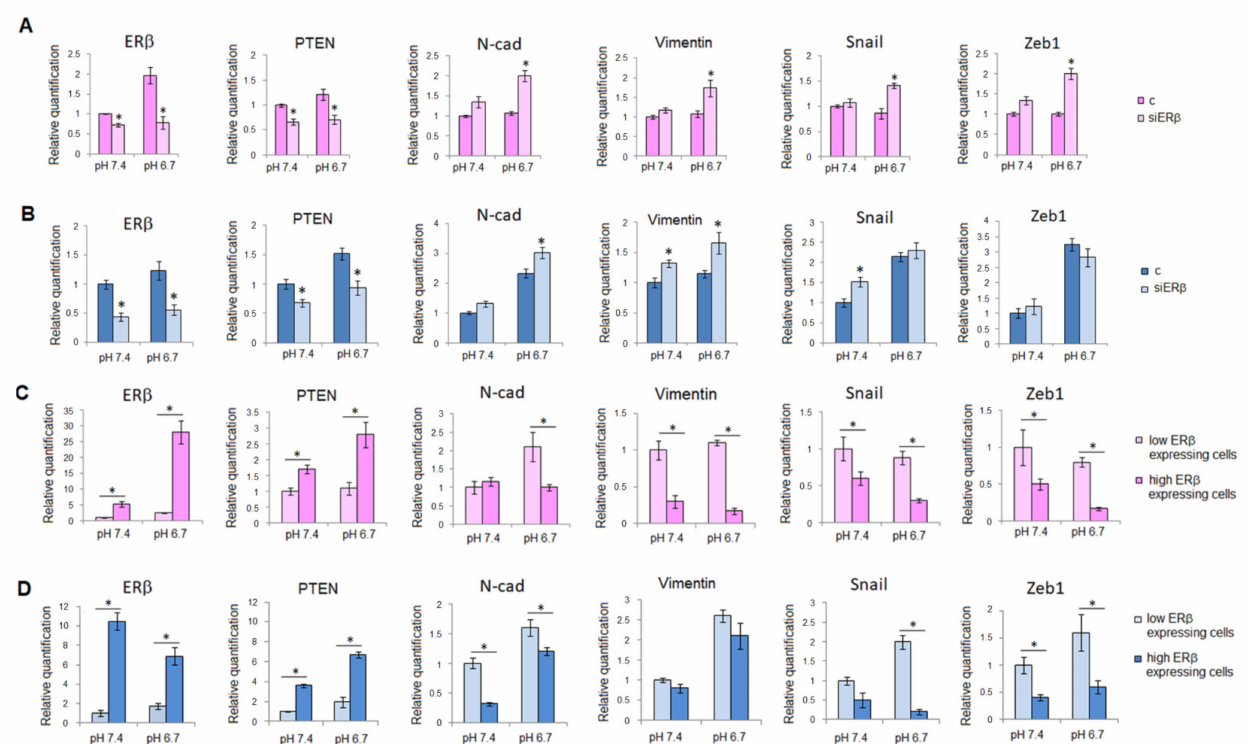
Figure 3. EMT regulation by ER β . mRNA level of ER β and EMT markers of M51 female ( A ) and SSM2c male ( B ) melanoma cells silenced for ESR2 and grown in standard or acidic medium for 24 h. ( C ) mRNA level of ER β and EMT markers of ER β low and high expressing M51 female melanoma cell subpopulations. ( D ) mRNA level of ER β and EMT markers of ER β low and high expressing SSM2c male melanoma cell subpopulations. Histograms represent the mean ± SEM of at least three independent experiments. * p < 0.05 compared with control